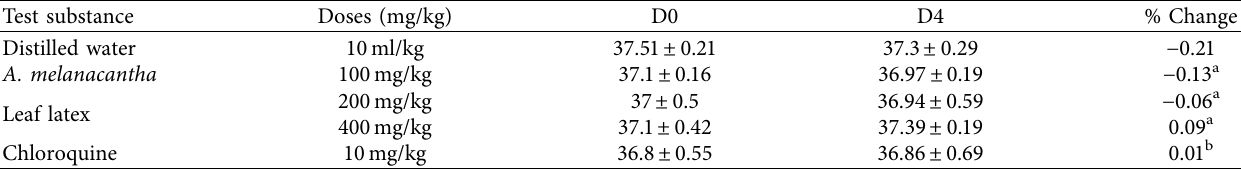
Table 4: Effect of A. melanacantha leaf latex on body temperature of Plasmodium berghei infected mice.